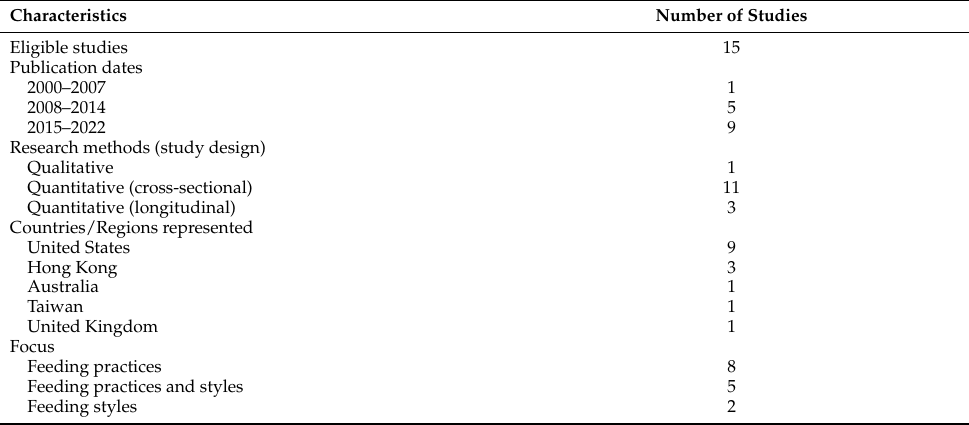
Table 3. Description of studies included in the integrative review (n =